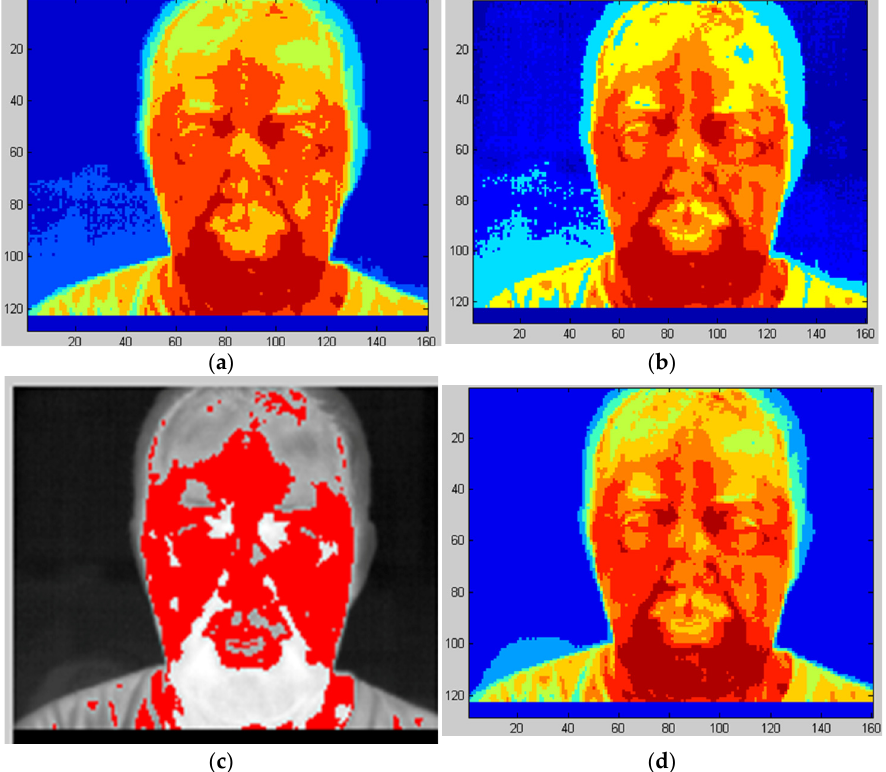
Figure 2. Various types of isothermal regions on the face. ( a ) Eight equal in length segments of the histogram (0–255). ( b ) Eight segments of the histogram equal populated. ( c ) A single isothermal region isolated on the image. ( d ) Arbitrary determination of the isothermal regions based on the minima of the histogram.